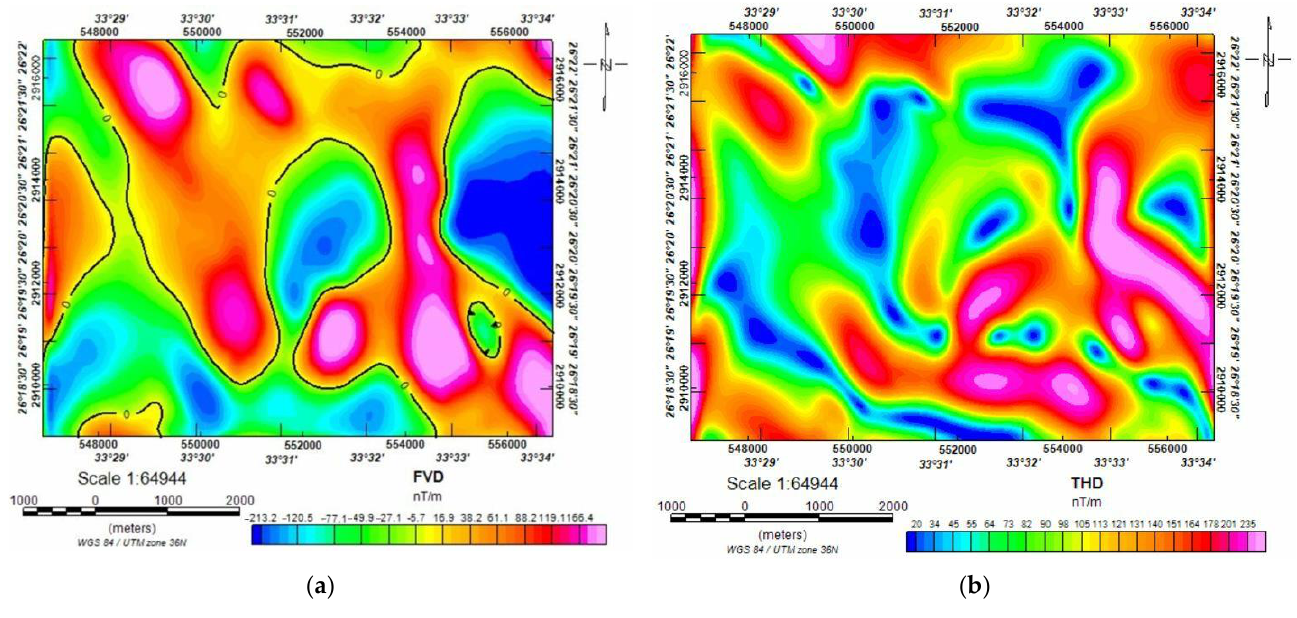
Figure 8. ( a ) First-order vertical derivative (FVD) map of the research area. ( b ) Total Horizontal Derivative (THD) map.